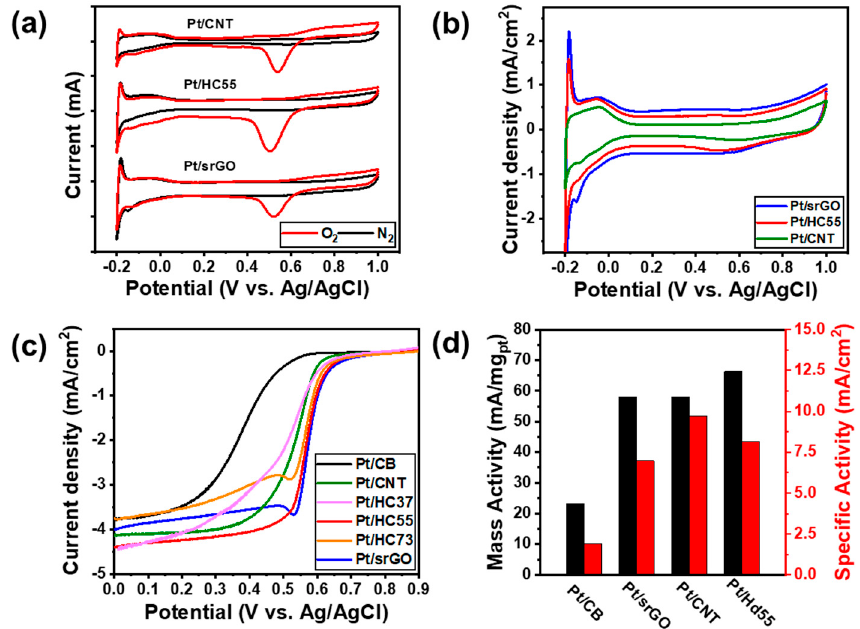
Figure 4. ( a ) CV curves of Pt/CB, Pt/CNT, Pt/srGO, Pt/HC37, Pt/HC55, and Pt/HC73 in N 2 − saturated (black lines) and O 2 − saturated (red lines) 0.5M H 2 SO 4 at a scan rate of 20 mV/s. ( b ) CV curves of the catalysts in N 2 − saturated 0.5 M H 2 SO 4 at a scan rate of 20 mV/s. ( c ) Polarization curves of the catalysts in O 2 − saturated 0.5 M H 2 SO 4 at a scan rate of 5 mV/s and GCE rotational speed of 1600 rpm. ( d ) Mass and specific activities of the catalysts at 0.4 V vs. Ag/AgCl.